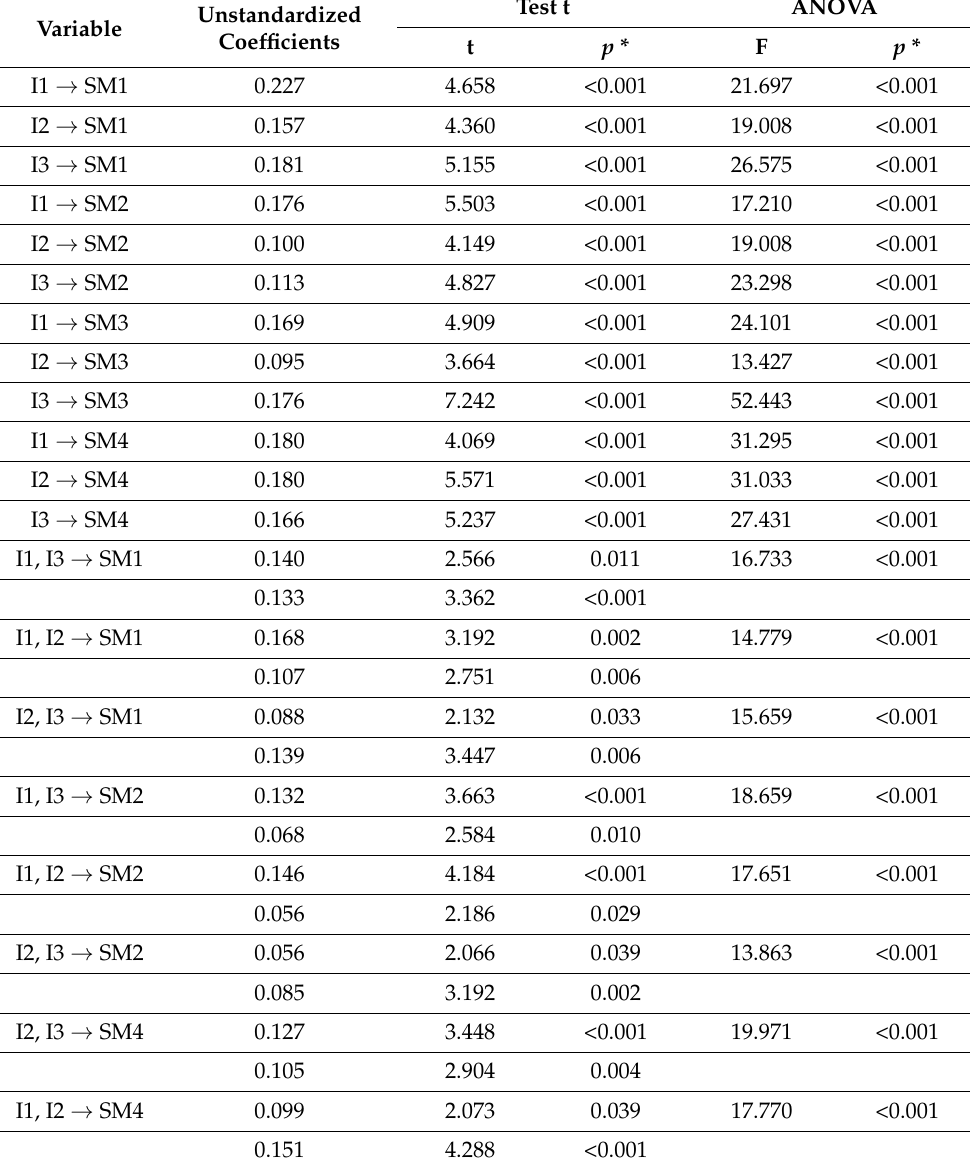
Table 8. Sustainability vs. Smart Mobility—linear regression